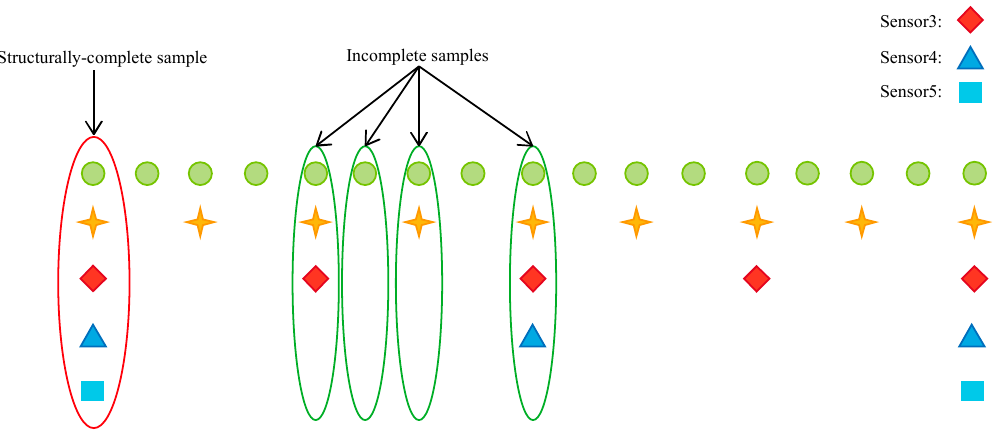
Figure 1. Different sampling rates of sensors. Figure 1. Di ff erent sampling rates of